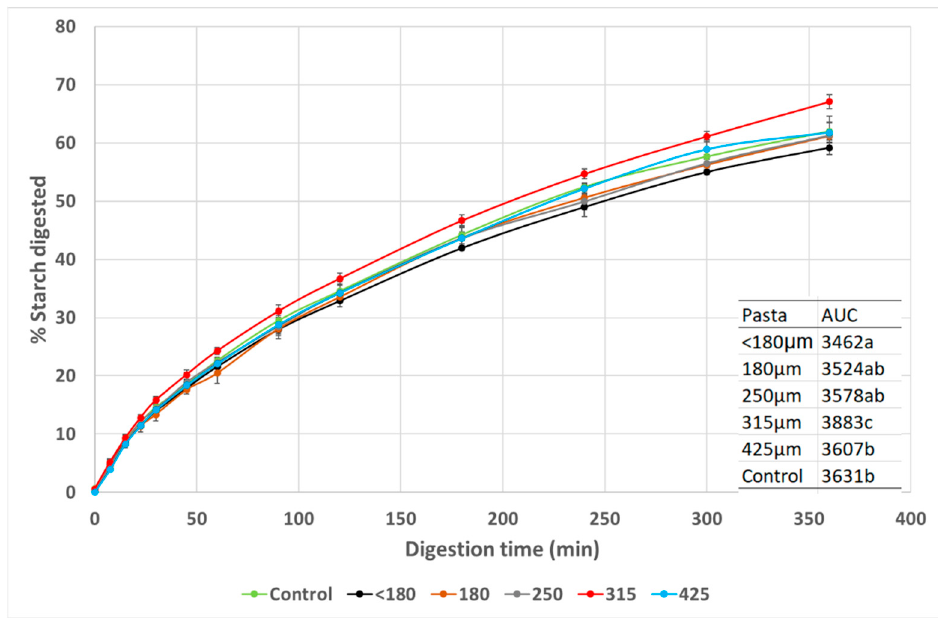
Figure 1. Effect of semolina particle size on pasta starch digestion curves. Data points are mean values (n = 3) with error bars as SD.